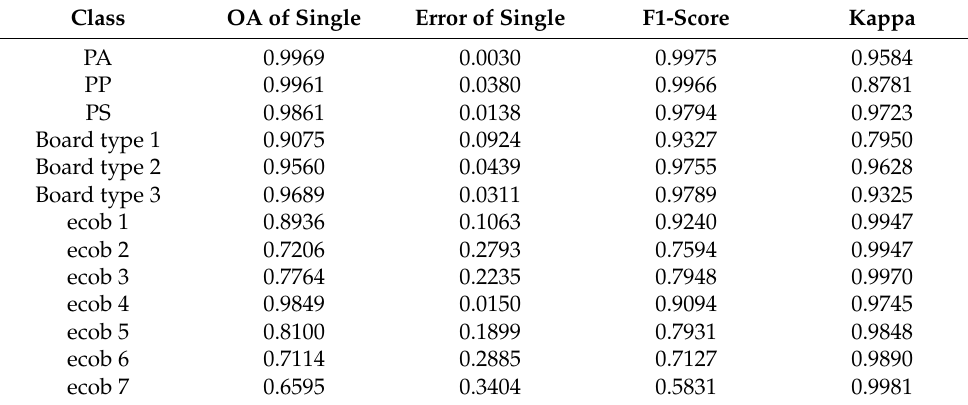
Table 1. Classification accuracies for each class based on 3D and HSI data.